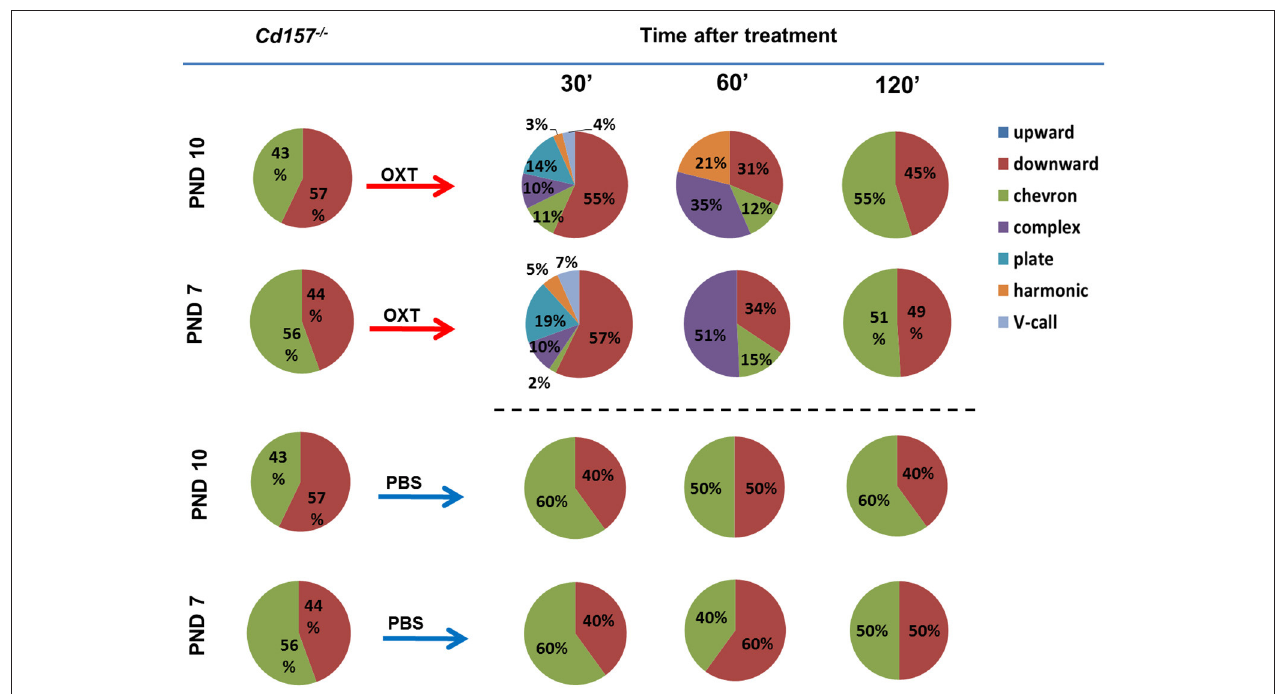
FIGURE 3 | Oxytocin treatment affects the USV pattern in Cd157 − / − pups at PNDs 7 and 10. Call category variations of USVs emitted by mouse pups at PNDs 7 and 10 were classified after 30, 60 and 120 min of intraperitoneal injection of OXT (10 ng/mouse) or PBS. Percentages were calculated as the number of calls in each category for each subject/total number of calls analyzed in each subject (Number of pups tested = 10–15; number of calls analyzed = 80–100). The calculated data of calls are presented in the Supplementary Tables 2 , 3